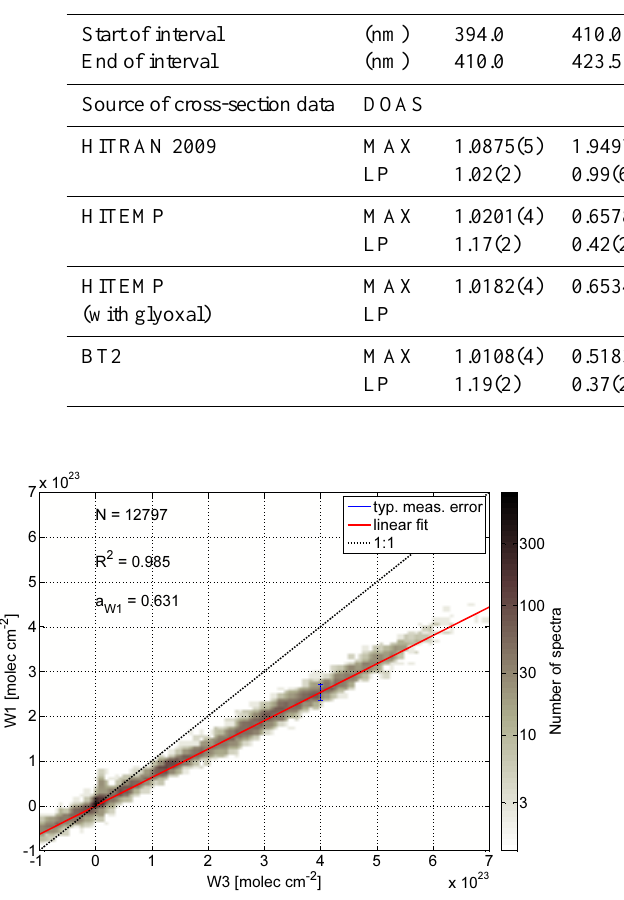
Figure 3. Correlation of dSCD in moleccm − 2 calculated for W1 (7 ν + δ polyad) and W3 (7 ν polyad) from MAX-DOAS (M91) data using the HITEMP cross-section. The blue error bar (at S W3 = 4 × 10 23 moleccm − 2 ) indicates a typical measurement er- ror. The convolved cross-section derived from the HITEMP compi- lation shows a maximum absorption cross-section of an individual absorption line in 5.9 × 10 26 cm − 2 and 4.0 × 10 25 cm − 2 for W1 and W3 respectively. The linear relationship of W1 and W3 domi-